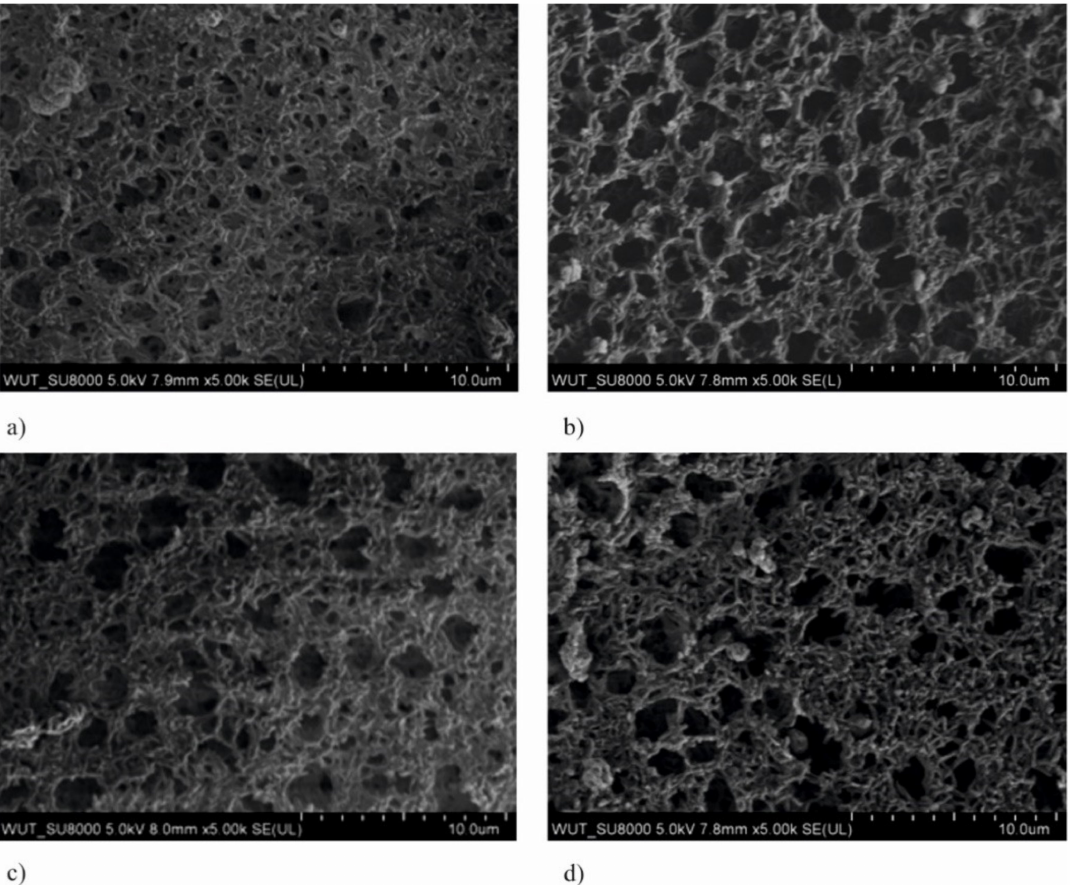
Figure 3. SEM images of the membranes with TiO 2 + CuO coatings deposited at different magnetron powers P M ( a ) P M-Cu = 100 W, P M-Ti = 650 W, t = 30 s, ( b ) P M-Cu = 200 W, P M-Ti = 650 W, t = 30 s, ( c ) P M-Cu = 100 W, P M-Ti = 1000 W, t = 30